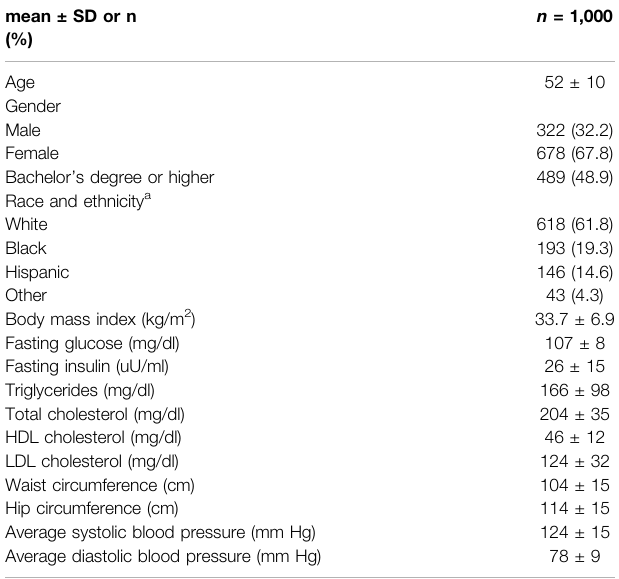
TABLE 1 | Demographic and clinical